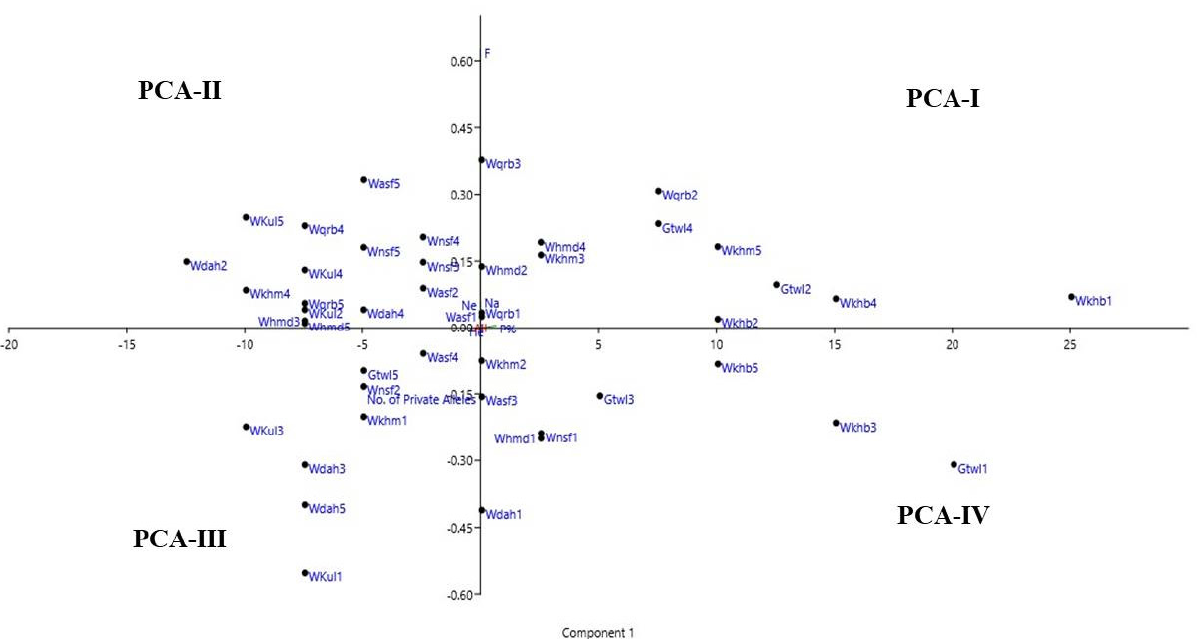
Figure 3. Principle component analysis (PCA) implemented for the studied populations of R. epapposum.